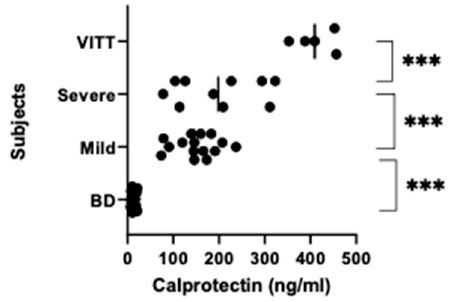
Figure 3. Calprotectin levels. Calprotectin levels were examined in the same samples as in Figure 2 by a mixed monoclonals (MiMo) ELISA. p < 0.0001 for one way ANOVA, for pairwise comparisons: *** p < 0.0001.